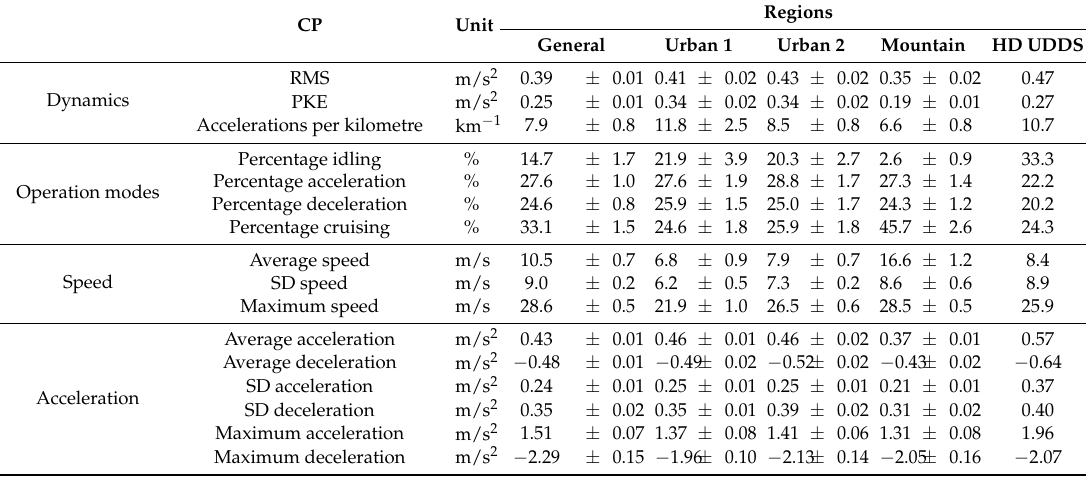
Table 3. Characteristic parameters (CPs) that describe the driving patterns followed by drivers during the monitoring campaigns at every region considered in this